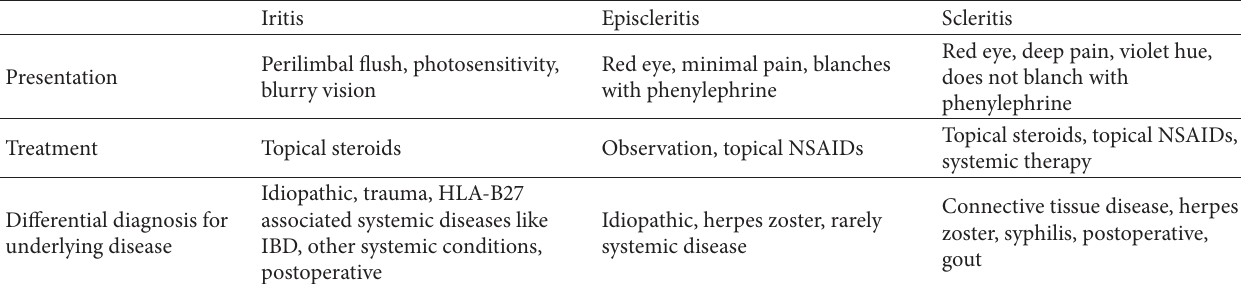
Table 1: Iritis versus episcleritis versus